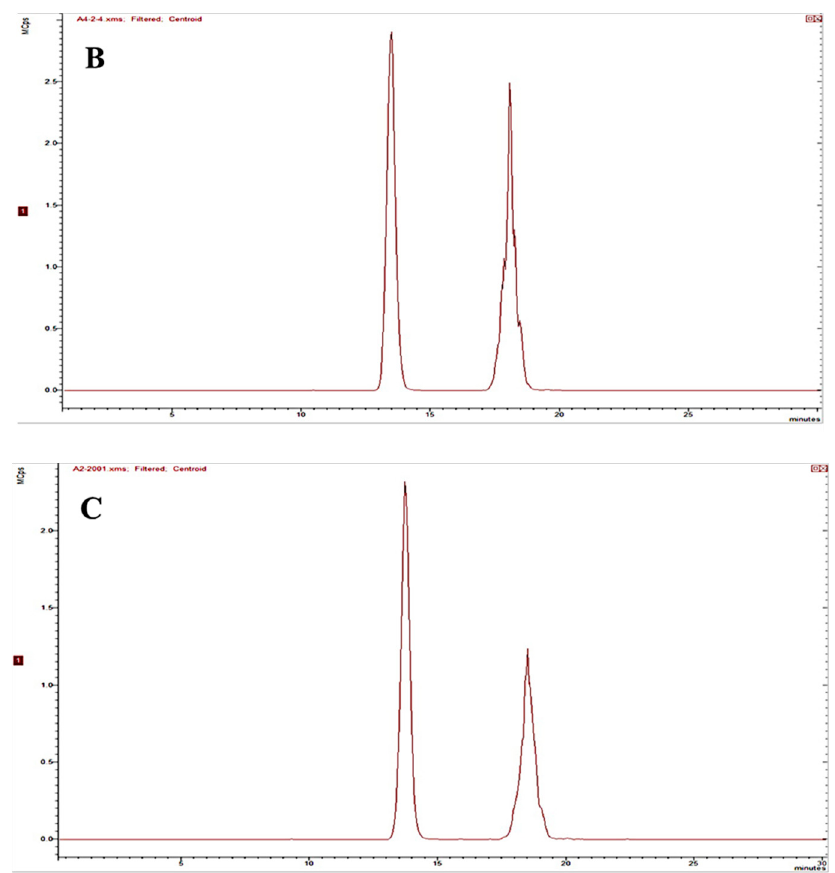
Figure 2. Typical chromatograms of blank rat plasma ( A ), blank rat plasma spiked with DPTM and IS ( B ), plasma sample 1 h after i.v. administration ( C ) of DPTM. The retention times of DPTM and IS